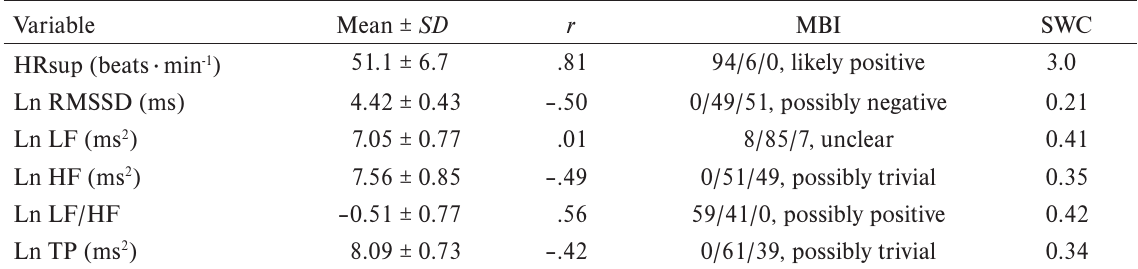
Note. r = Pearson’s correlation coefficient; MBI = magnitude based inference for r ; HRsup = heart rate in the supine position; Ln = natural logarithm; RMSSD = square root of the mean of the squares of the successive differences; LF = low-frequency power; HF = high-frequency power; LF/HF = low-frequency/high-frequency ratio; TP = total power